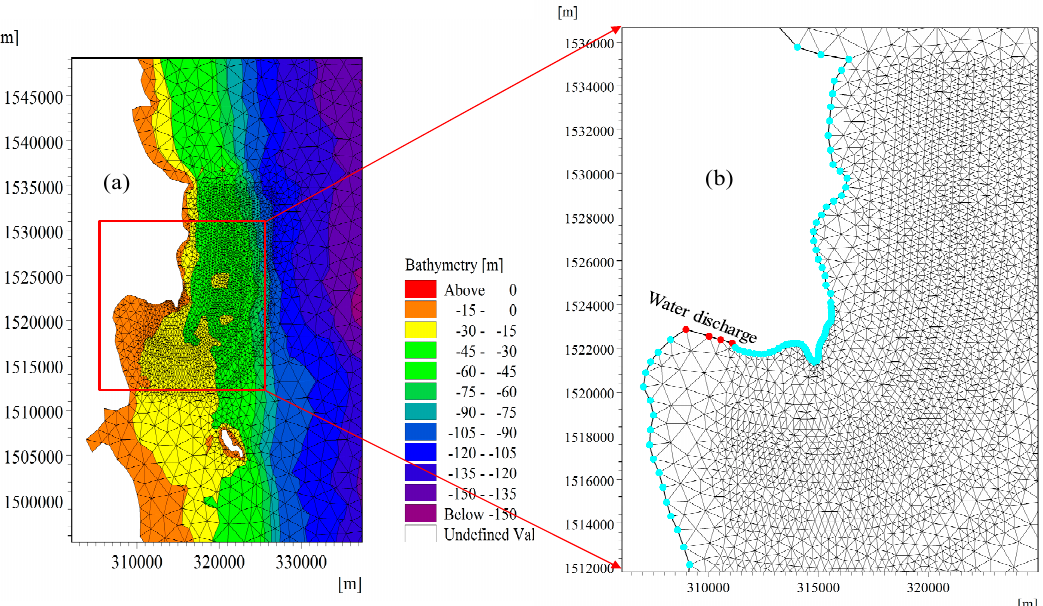
Figure 3. ( a ) 2D visualization bathymetry of wave mesh; ( b ) Detailed mesh of study area.